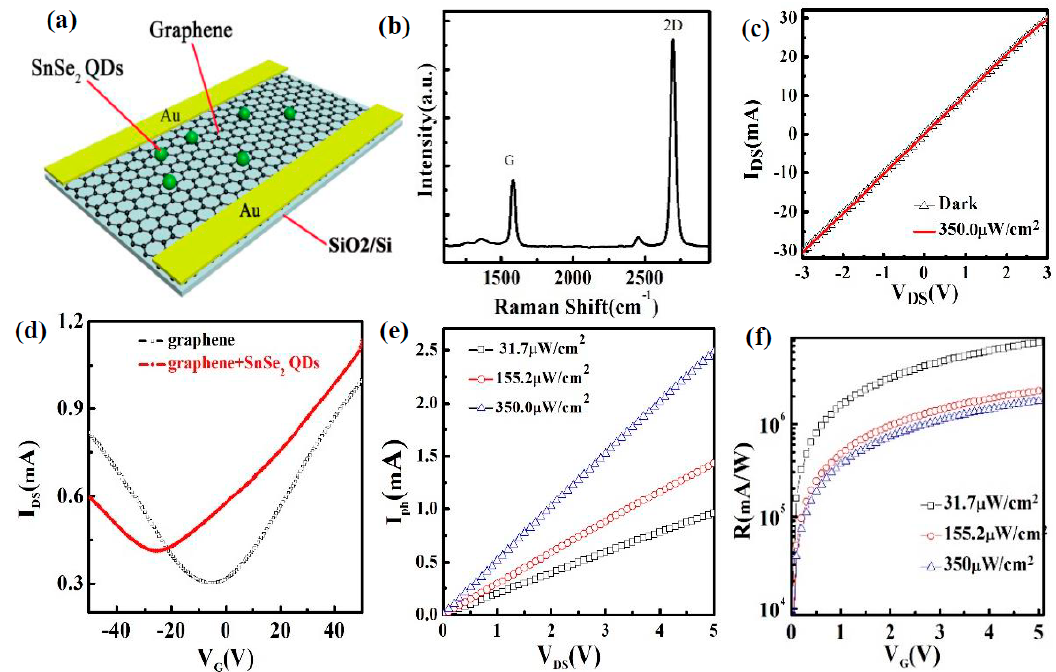
Figure 4. ( a ) Schematic diagram of a graphene photodetector decorated with SnSe 2 QDs; ( b ) Raman spectra of the pure graphene on a p + Si / SiO 2 substrate; ( c ) the I–V curves for the single-layer graphene phototransistor in the dark and with illumination under zero-gate voltage (V G = 0 V); ( d ) transfer characteristics (I DS -V G , V DS = 0.5 V) of the phototransistor with and without SnSe 2 QDs on the graphene film; ( e ) photocurrent and ( f ) responsivity of a SnSe 2 QD-decorated graphene photodetector as functions of drain voltages at different illumination densities. The illumination wavelength is 405 nm.